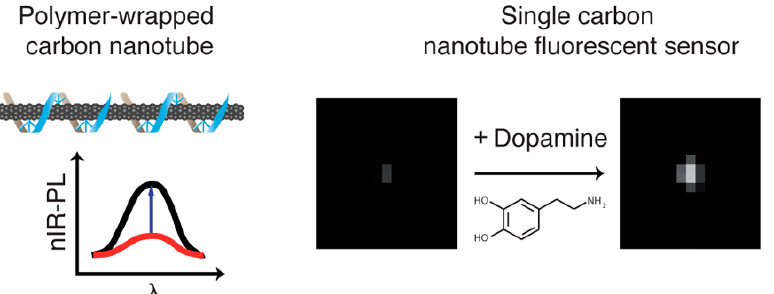
Figure 3. A polymer (blue) wraps a SWCNT, and provides a unique molecular recognition binding site for dopamine. Upon exposure to dopamine, the SWCNT near-infrared fluorescence signal increases up to 400% for a single SWCNT. The box dimension is 5 × 5 μm